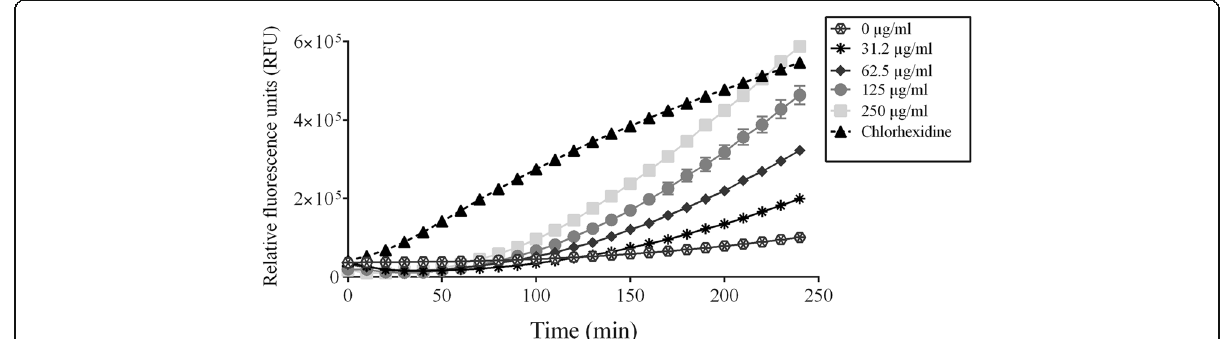
Fig. 2 Time-course release of calcein-AM by A. actinomycetemcomitans cells treated with various concentrations of highbush blueberry PACs. Chlorhexidine (200 μ g/ml) was used as a positive control. A significant ( p <0.01) release of calcein-AM was observed with PACs at 62.5, 125, and 250 μ g/ml following a treatment of bacteria for 120 min. To obtain the same significance, a treatment of 160 min was necessary when PACs were used at 31.25 μ g/ml